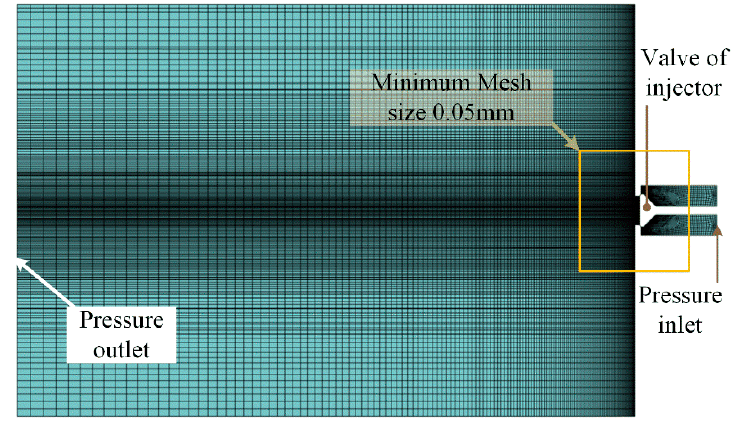
Figure 3. CFD calculation domain and mesh.